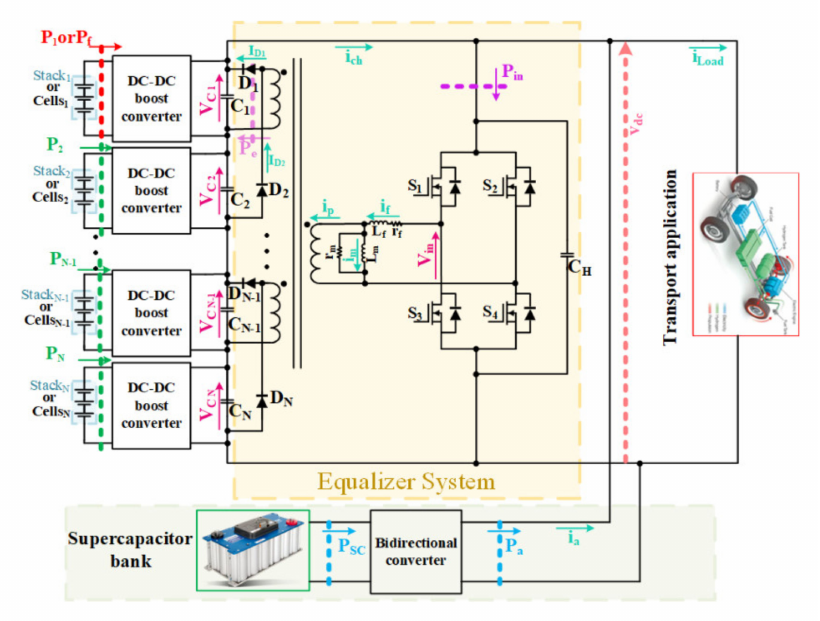
Figure 3. Proposed power electronic architecture to realize fuel cell management